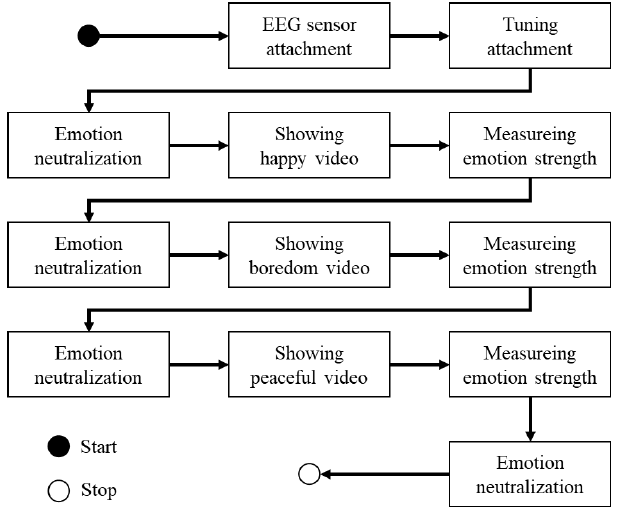
Figure 5. Data collection